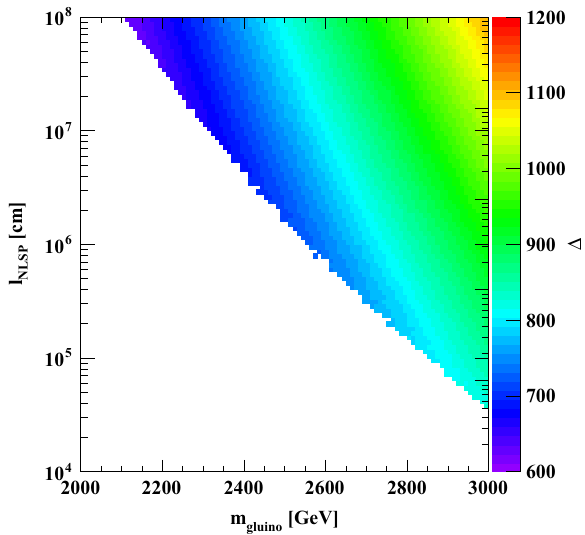
Fig. 1 Gluino mass vs. NLSP decay length c τ ˜ after applying all current LHC constraints. The colour map indicates the values of the fine-tuning measure